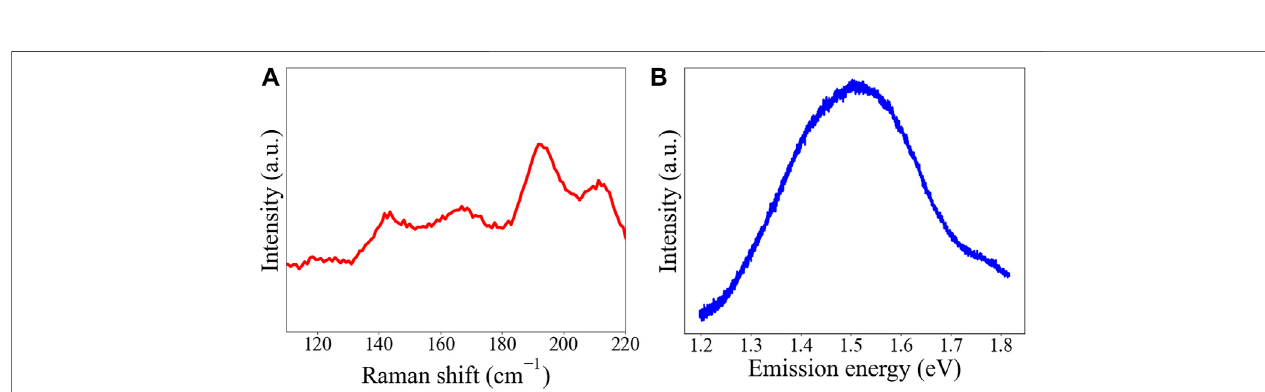
FIGURE 1 | RRAM device based on monolayer ReSe 2 . (A) 3D schematic and (B) optical image of fabricated ReSe 2 vertical MIM crossbar device with Au electrodes.